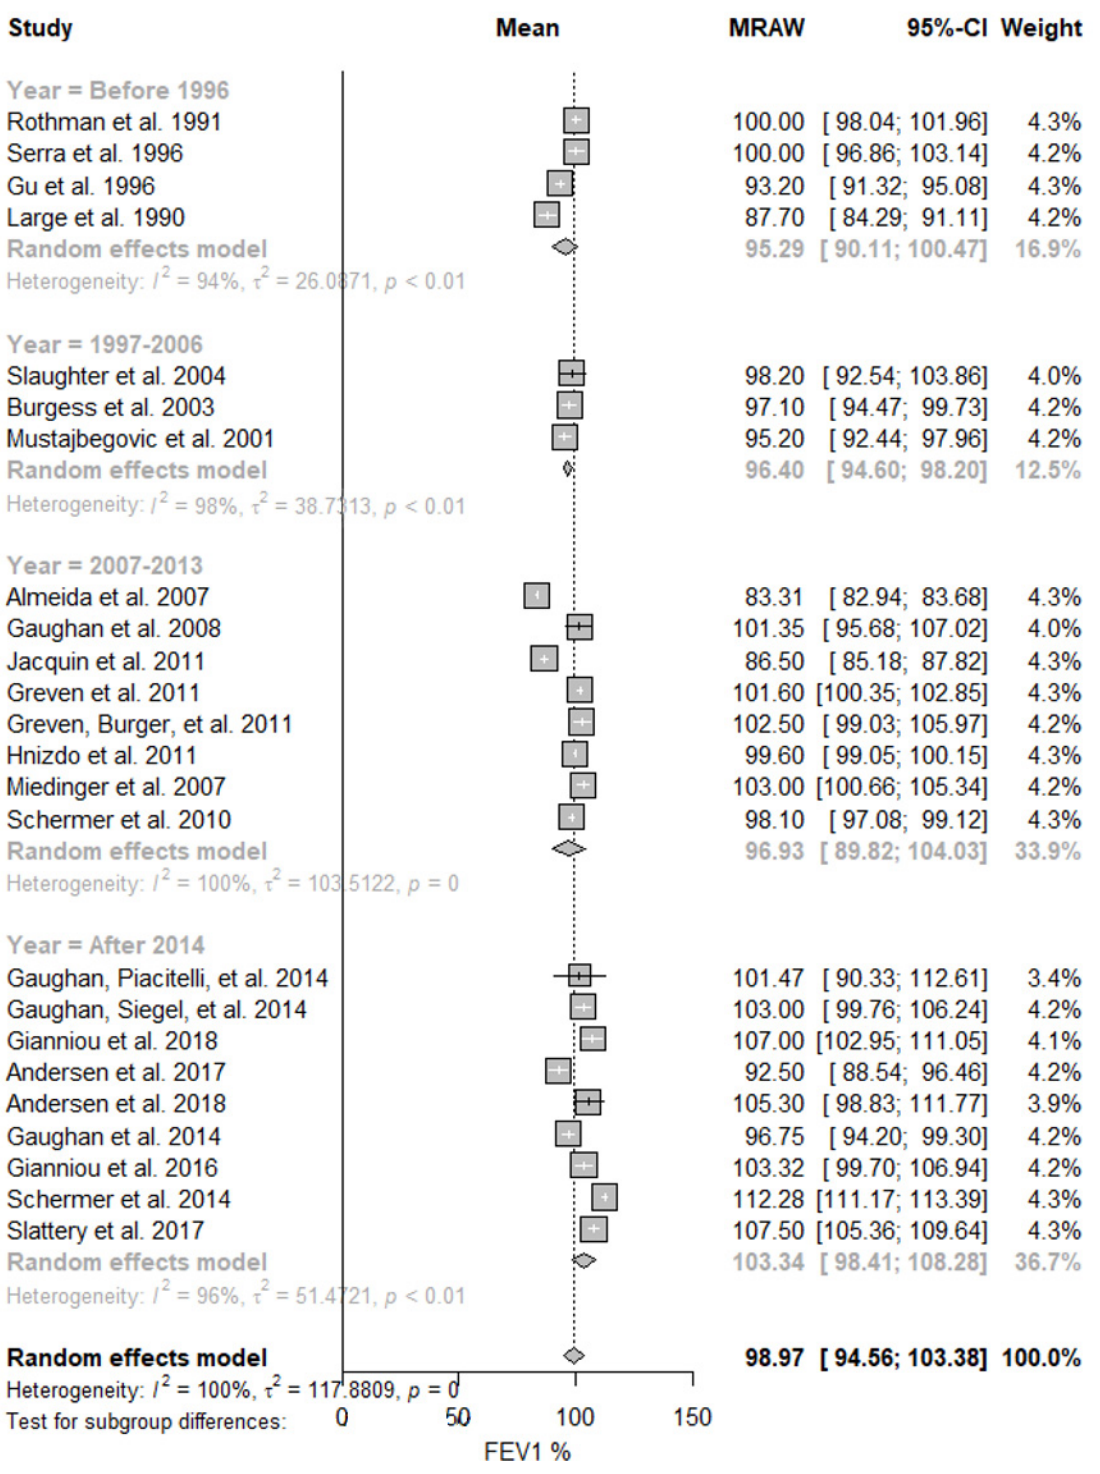
Figure 2. Predicted FEV 1 in firefighters stratified by studies’ publication year. Forest plot displaying the weight of the predicted FEV 1 mean value and heterogeneity [13,40–62].